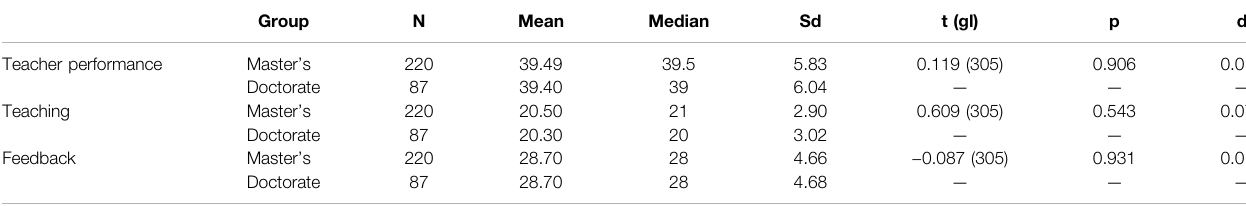
TABLE 6 | Comparison of perception of teacher performance and teaching and feedback factors according to postgraduate level.